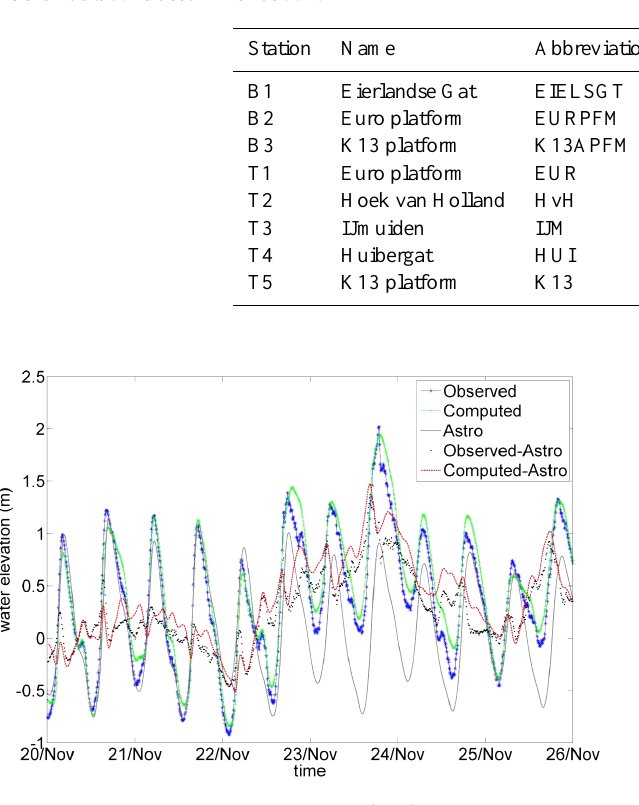
Table 4. Stations used in validation.